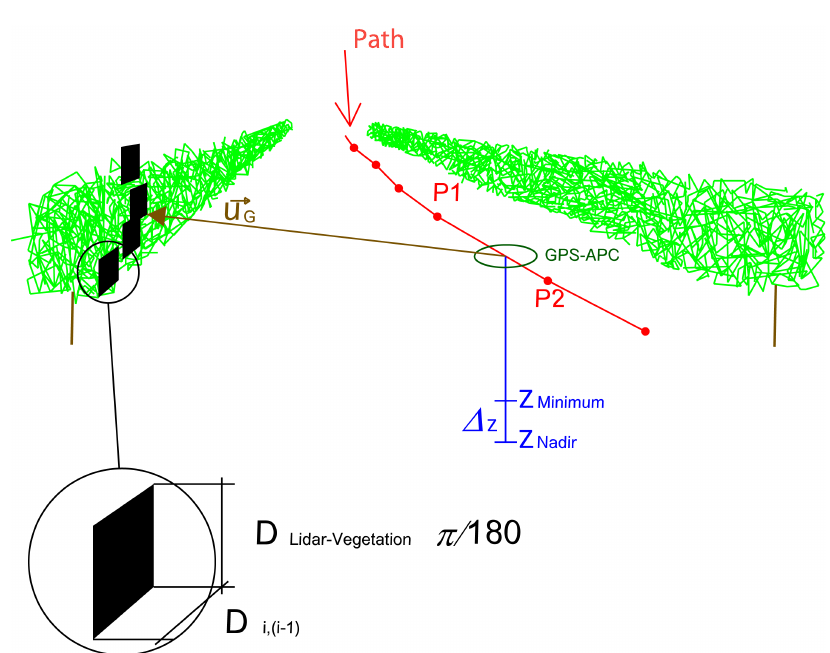
Figure 8. Minimum height to eliminate ground points and calculation of